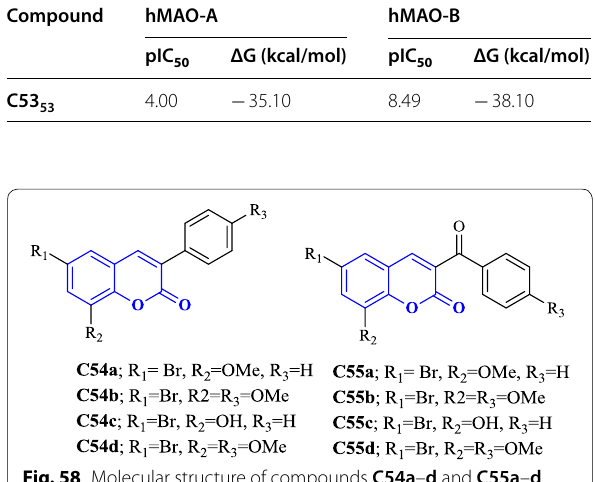
Fig. 58 Molecular structure of compounds C54a – d and C55a –